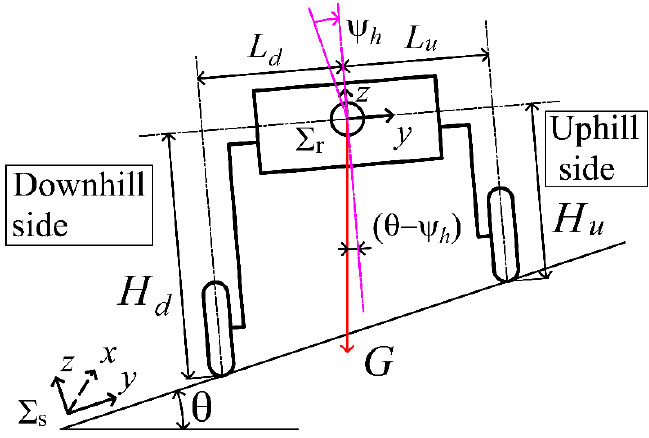
Figure 5. Definition of coordinate systems.